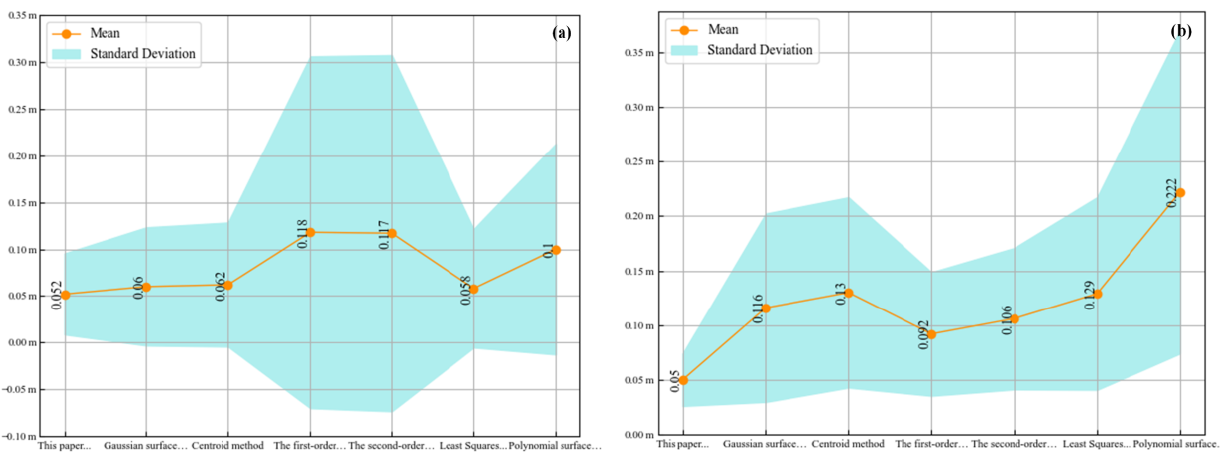
Figure 15. ( a ) Elevation accuracy verification of laser footprints for Beam 1 in 2021 positioned using different methods; ( b ) elevation accuracy verification of laser footprints for Beam 2 positioned using different